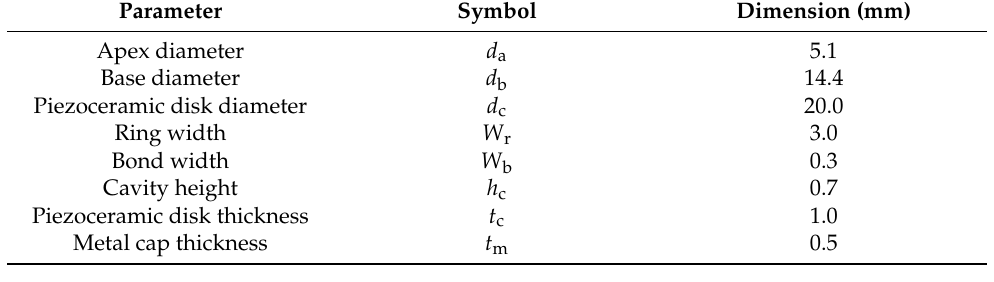
Table 2. Acoustic characteristics of the designed Tx 1 and two Tx 2 transducers.